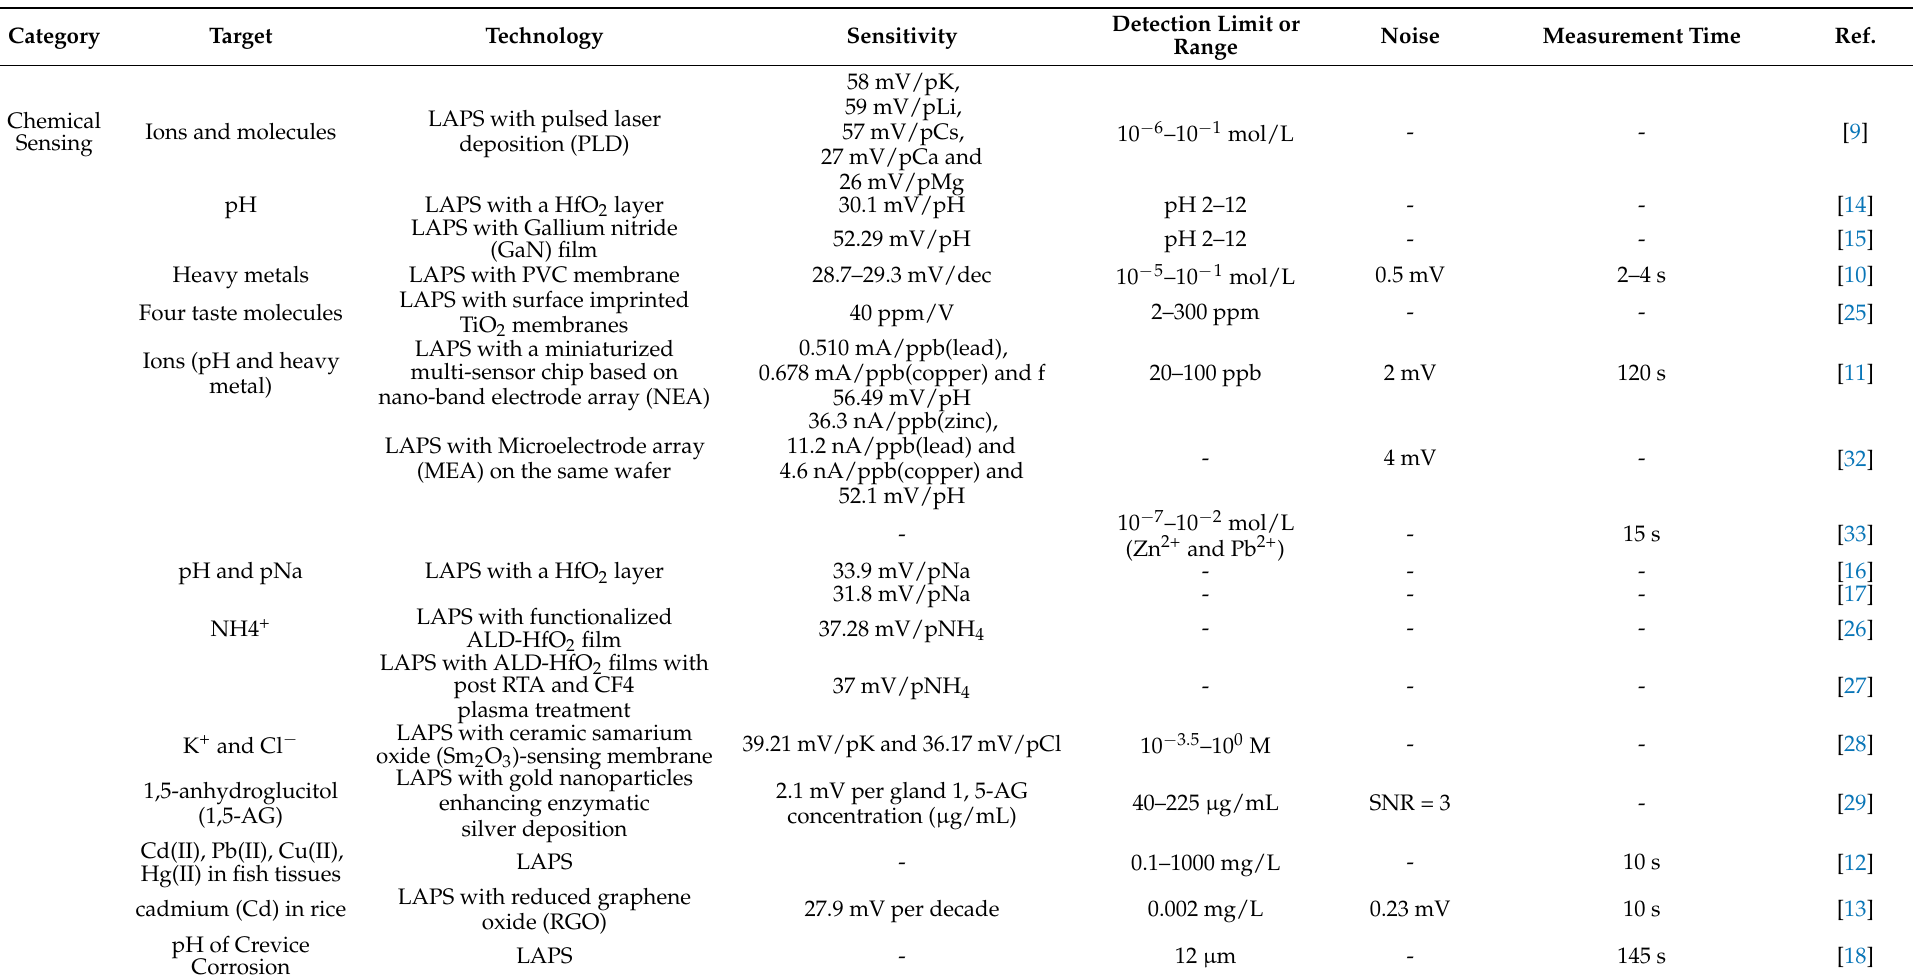
Table 1. Categories, targets, technology, detection limits or ranges, noise and measurement times of articles on LAPS chemical sensing and imaging published in recent